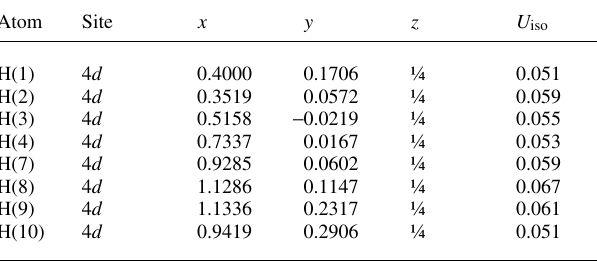
Table 2. Atomic coordinates and displacement parameters (in Å 2 )